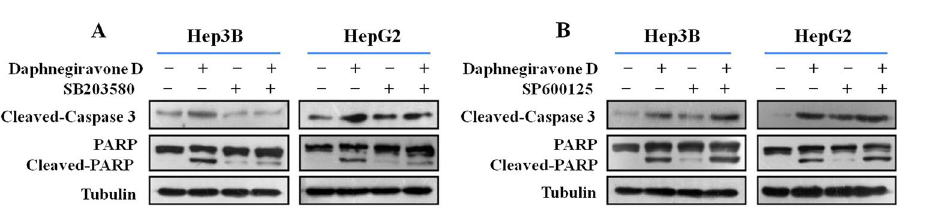
Figure 7. Effects of p38/JNK MAPK inhibitors on apoptosis induced by daphnegiravone D in HepG2 and Hep3B cells. Cells were pretreated with SB203580 (10 μ M) and SP600125 (10 μ M) for 1 h prior to daphnegiravone D treatment (2 μ M for Hep3B cells and 10 μ M for HepG2 cells) for 48 h. ( A , B ) The expression levels of cleaved-caspase 3 and -PARP were detected by Western blot in both hepatoma cells. Tubulin was used as a loading